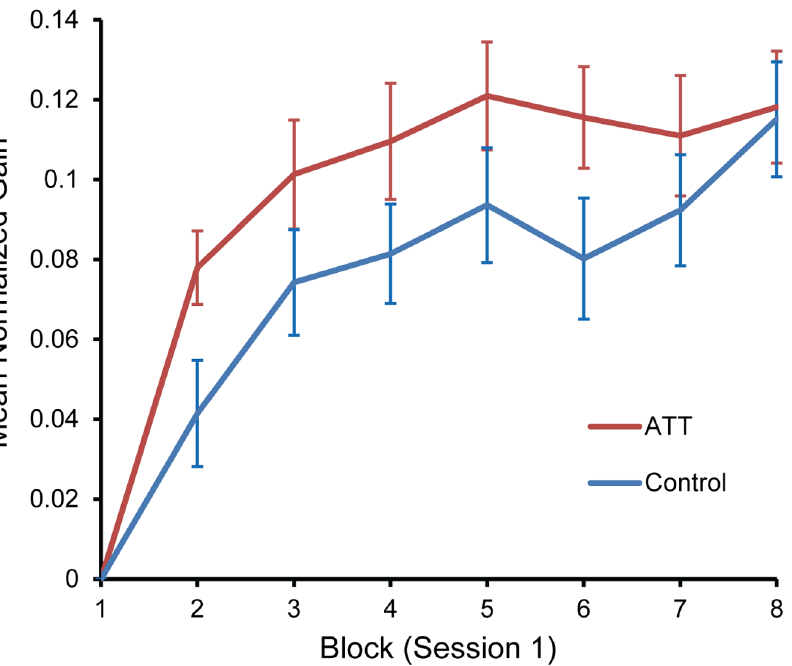
Figure 2. Online (within-session) gains. Group means for mean performance gains in Session 1, normalized to performance in the first block of the session, by Training Condition (ATT, Control). ATT=attend-threat training. Error bars signify 6 1 s.e.m.